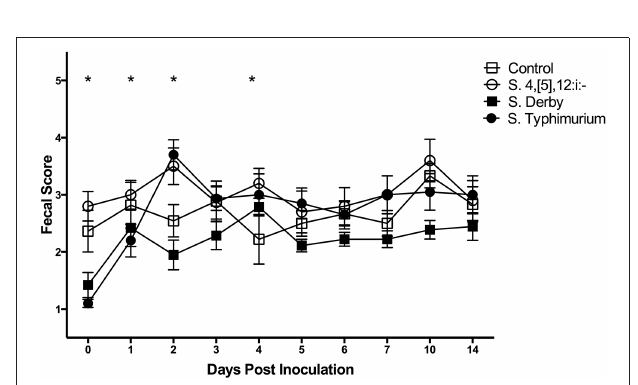
FIGURE 5 | Comparison of fecal scores of pigs inoculated with Salmonella serovars 4,[5],12:i:-, Typhimurium, and Derby and non-inoculated control pigs in animal study #2. Symbols represent the mean, with vertical bars representing standard error of the mean. Fecal scores of 1–2 are normal, 3 is mild diarrhea, 4 is moderate diarrhea, and 5 is severe diarrhea. Days with significant differences present are represented by asterisks and are detailed in the